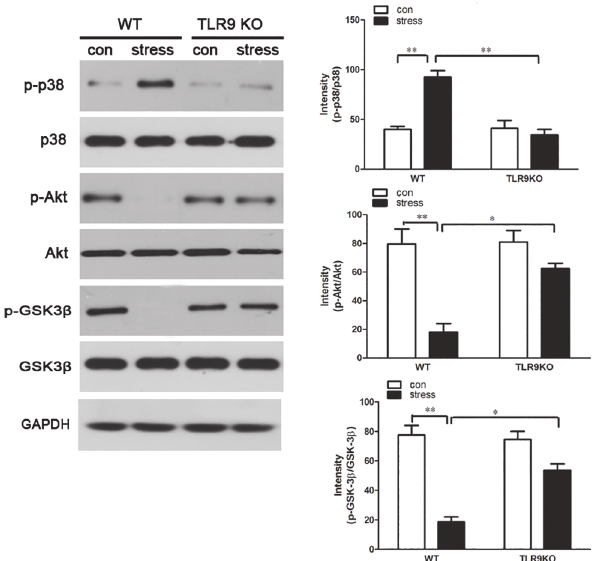
Fig 6. TLR9 deficiency attenuates chronic stress-induced changes of apoptosis related pathways TLR9 knockout mice or wild type BALB/c mice aged 6 to 8 weeks were subjected to a 12 h physical restraint daily. After 2 d stress, mice were sacrificed by cervical dislocation, and the macrophages were harvested, purified and cultured (5 × 10 5 cells/well) on culture plates for 24 hours. The expression of total and phospho-p38, total and phospho-Akt, total and phospho-GSK-3 β were analyzed by Western blot. Means and SEs were calculated from 7 mice per group. * p < 0 . 05 , ** p < 0 . 01 compared with indicated